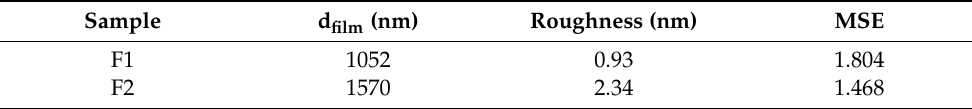
Table 2. Thickness (d film ), roughness, and fit error (MSE).